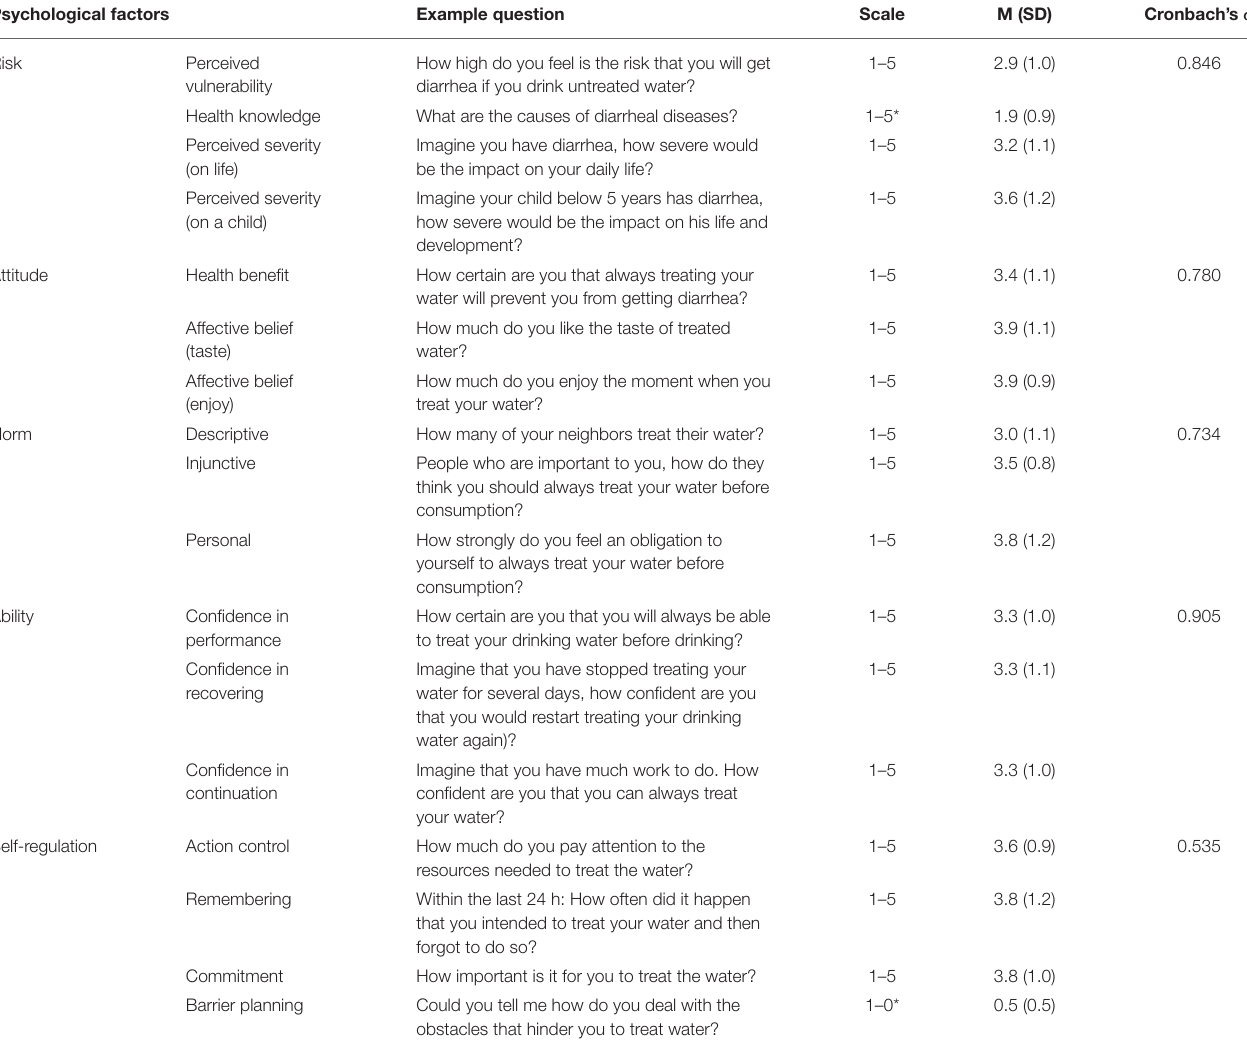
TABLE 1 | Descriptive statistics of psychological